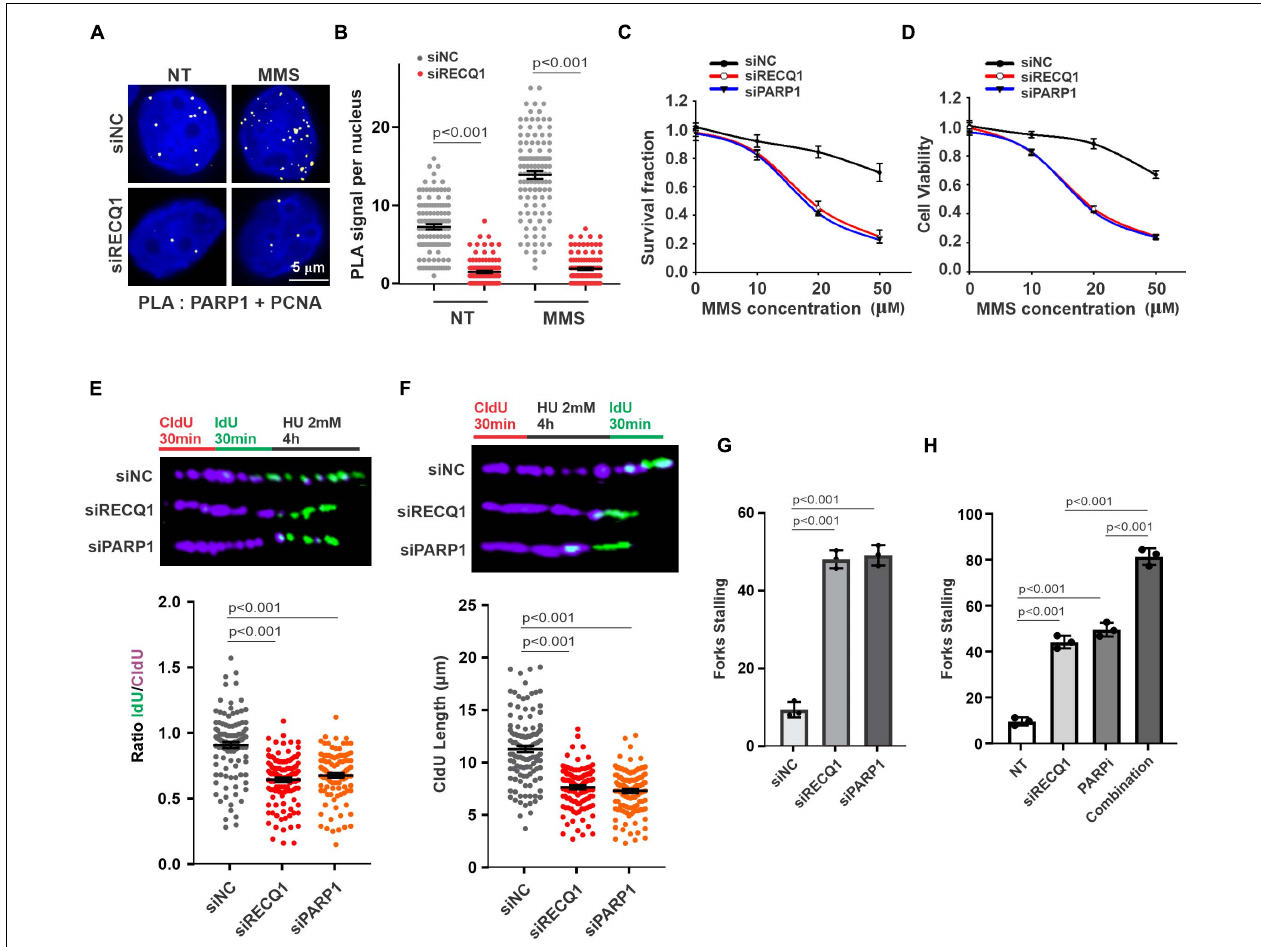
FIGURE 4 | RECQ1 function on GBM cells growth by mediating PARP1 pathway. (A) Detection of PARP1-PCNA interaction was carried out by PLA labeling in M059K cells treated with or without 50 µ M MMS after transfection with siNC or siRECQ1. Representative images are shown. Scale bars, 5 µ m. (B) The scatterplot displays quantification of the PLA signals per nucleus from three independent experiments. Data are mean ± SEM. (C) Quantification of colony formation assay of cells transfected with siNC, siRECQ1 or siPARP1 exposed to different concentration of MMS. (D) The viability of siRECQ1 transfected M059K cells was measured with a CCK8 kit. (E) Schematic of the CldU/IdU pulse-labeling analysis used to investigate replication fork degradation upon HU treatment in M059K cells transfected with siRECQ1 or siPARP1 for 48 h. Representative images of CldU and IdU replication tracks (top) and scatterplot of IdU/CldU-tract length ratios (bottom) for replication forks are shown. Fiber evaluated from at least 100 events from three independent experiments. Data are mean ± SEM. (F–H) Schematic of an alternative CldU/IdU pulse-labeling protocol to investigate fork degradation and fork stalling upon HU treatment in M059K cells of CldU tracking length and stalled forks are assayed. Fiber evaluated from at least 120 events from three independent experiments. Data are mean ± SEM. A two-sided Mann–Whitney rank-sum test was used to determine if differences were significant (B,E,F) . A two-sided unpaired t -test was used to calculate P -values (C,D) . Significant: p < 0.05; NS, not significant: P >